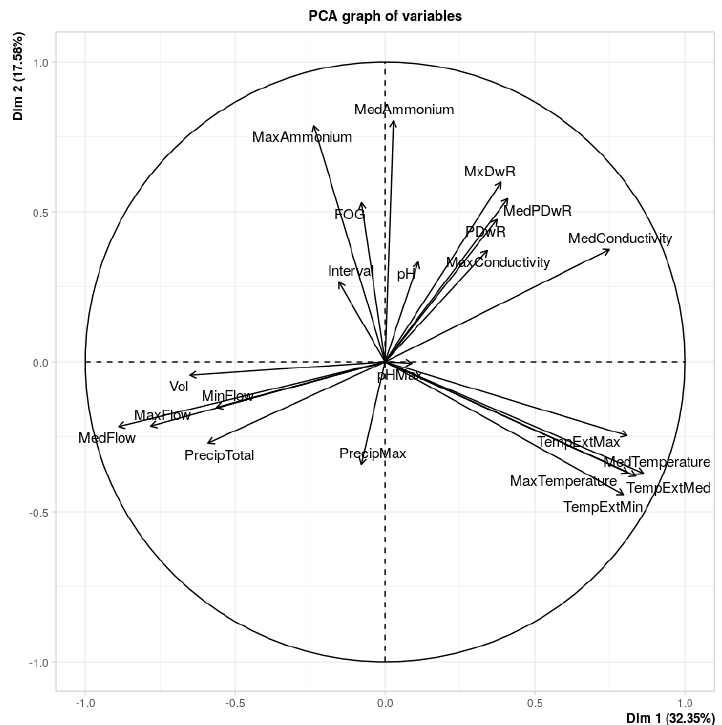
Figure 3. PCA graph of variables.